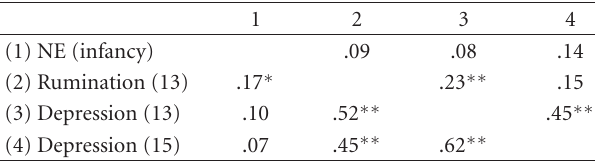
Table 2: Correlation matrix for overall negative emotionality, rumination, depressive symptoms, and